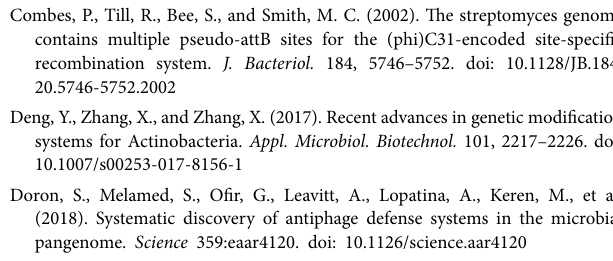
Figure S2 ). For example,